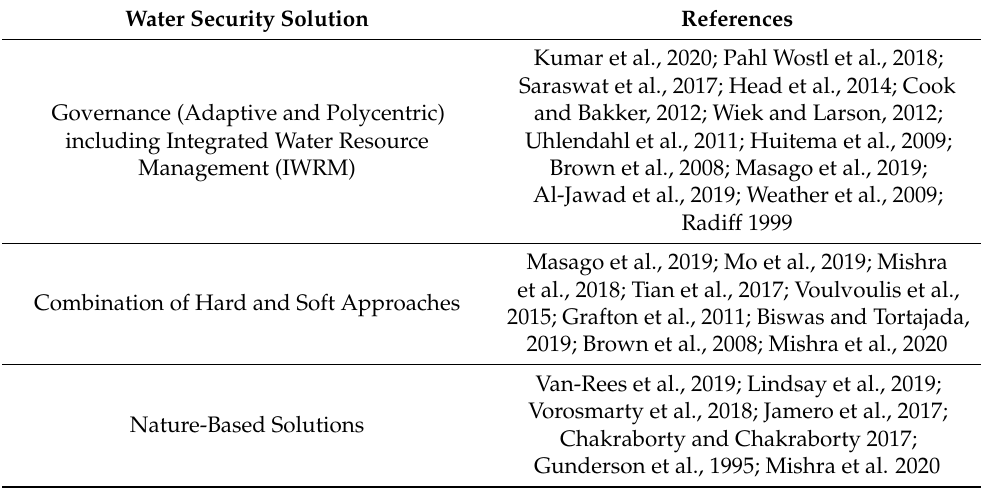
Table 1. List of reviewed papers used to find water security solutions under following three different